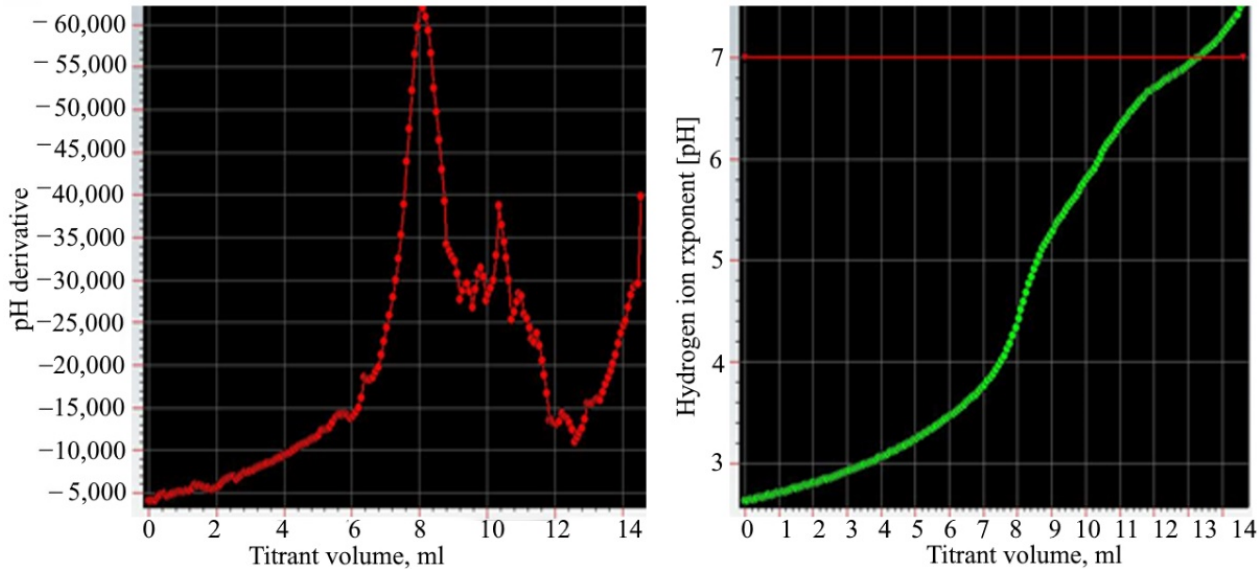
Figure 2. The differential and integral titration curves.